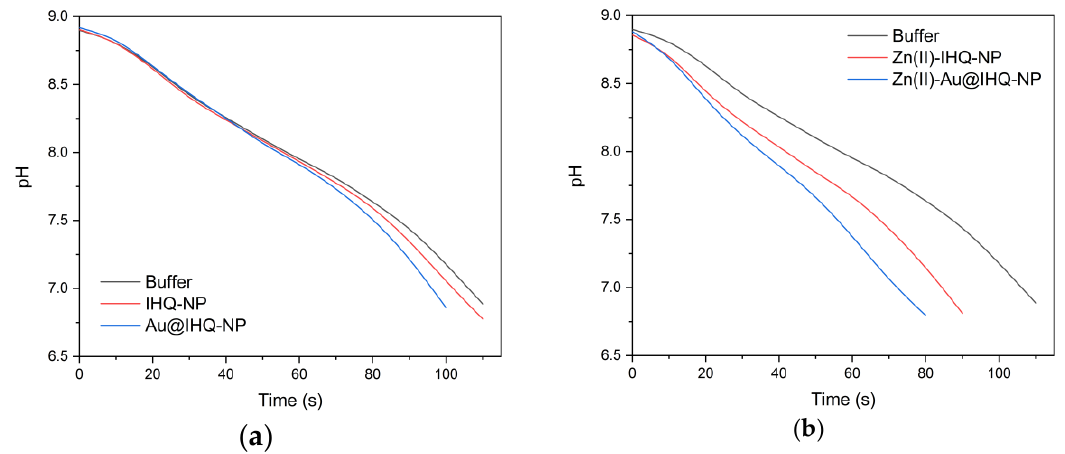
Figure 4. CO 2 -hydration activity via delta-pH of IHQ-NP and Au@IHQ-NP in ( a ) the absence or ( b ) the presence of Zn(II). CO 2 -hydration was performed in 50 mM Tris/HCl buffer pH 8.9 either in the absence of ZnCl 2 ( a ) or containing 100 µM ZnCl 2 ( b ). 10 µM (immobilized) IHQ-NP was used, while CO 2 flow rate was kept constant at 0.1 L/min.